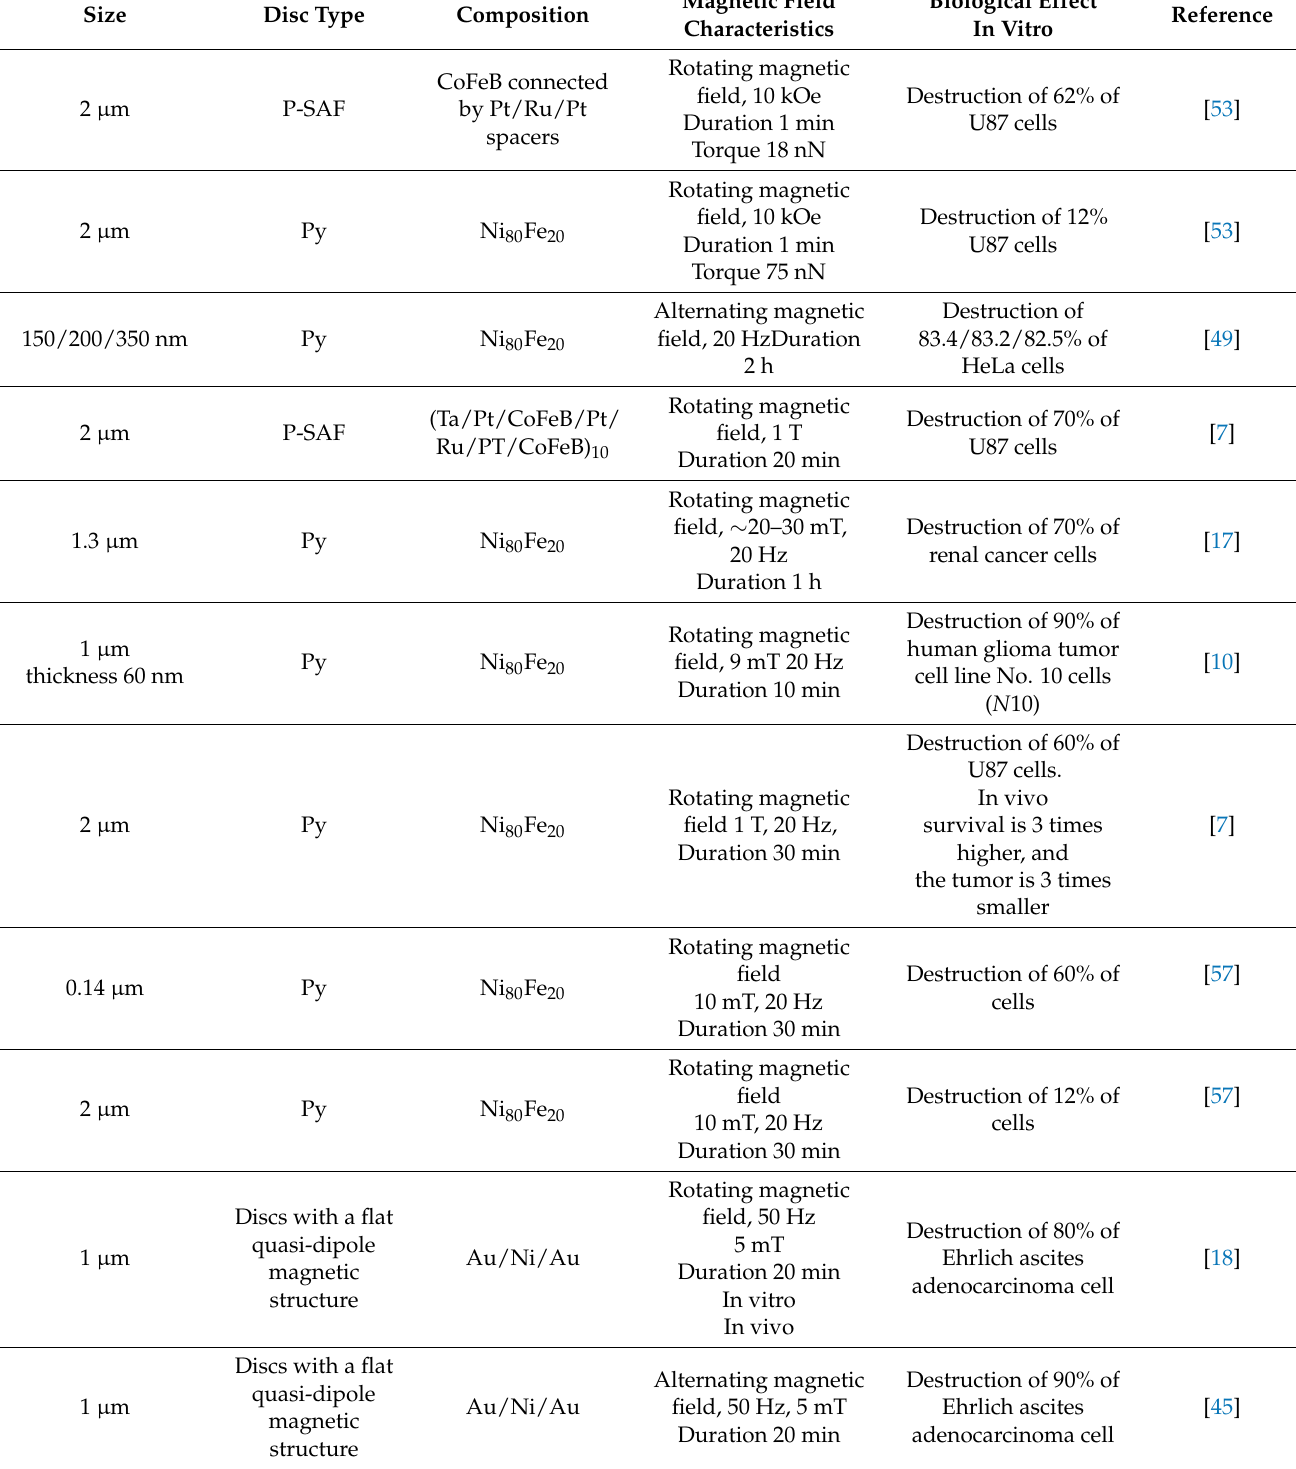
Table 1. The biological effect of magnetic antiferromagnetic (SAF and P-SAF) and vortex Py nano- and microdiscs and discs with a flat quasi-dipole magnetic